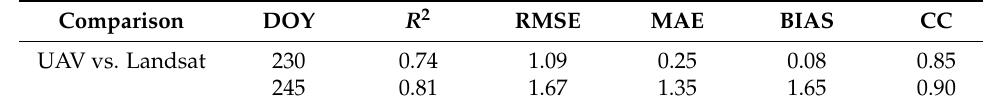
Table 9. Statistical performance of the UAV with Landsat 8 measurements.